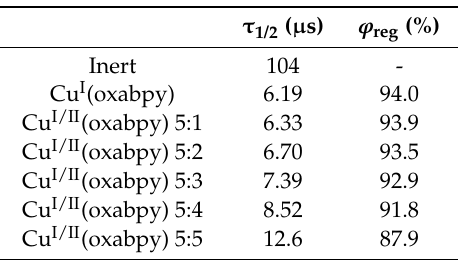
Table 3. Regeneration times and efficiencies for Y123-sensitized photoanodes in inert and Cu(oxabpy) electrolyte, by addition of Cu II into the electrolyte.